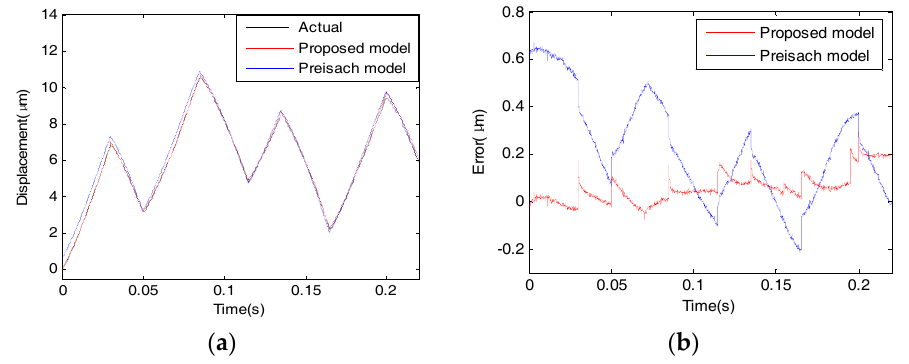
Figure 19. The responses to the random triangular excitation with high rate. ( a ) The output displacement curves; ( b ) error curves. Table 7. The modeling errors with sinusoidal excitations.